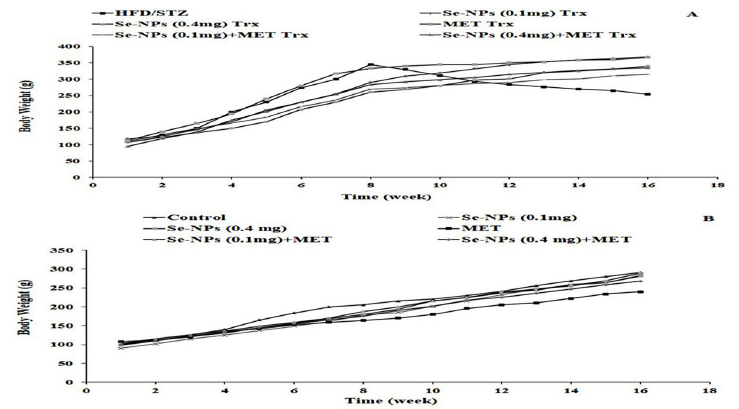
HFD/STZ-induced T2DM resulted in a significant increase (P < 0.01) in fasting blood glucose levels (387 ± 5.5 mg/dl) compared with control rats. The diabetic rats treated with two doses Se- NPs (0.1 or 0.4 mg/kg) a monotherapy for 8 weeks showed a significant reduction (P < 0.01) in the fasting blood glucose level that was noted compared to the untreated diabetic rats (3 fold decrease) (Table 2). Further, the treatment with standard anti-diabetic drug MET (100 mg/kg) was linked with a significant (P < 0.01) improvement in fasting blood glucose levels in diabetic rats. Moreover, the strategy of combined therapy in the treatment of diabetic rats (0.1 mg/kg Se-NPs-MET) and/or (0.4 mg/kg Se-NPs-MET) were displayed more efficient anti-hypergly- cemic activity than Se-NPs or MET alone with maximum decline (P < 0.01) in blood glucose levels compared to untreated rats with levels near to the control values.